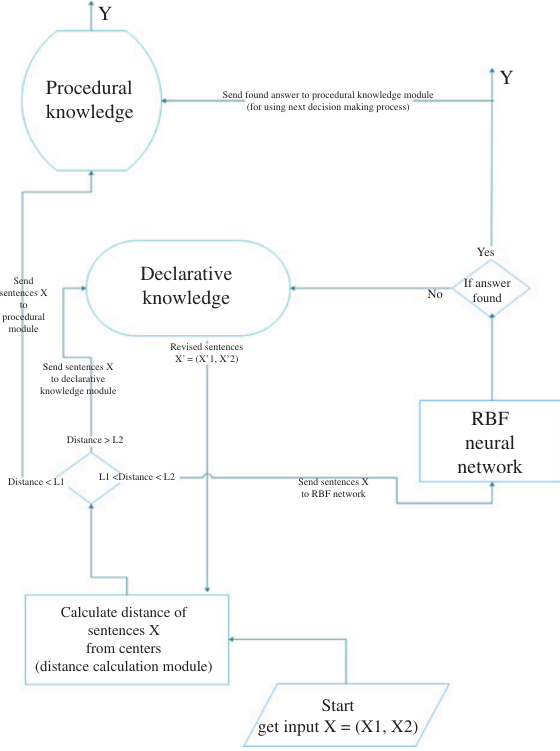
Figure 4: Interaction Diagram of Input with Declarative Module for Recreating Rules of Input Sentence by User of Saved Hypoth- esis in the Declarative